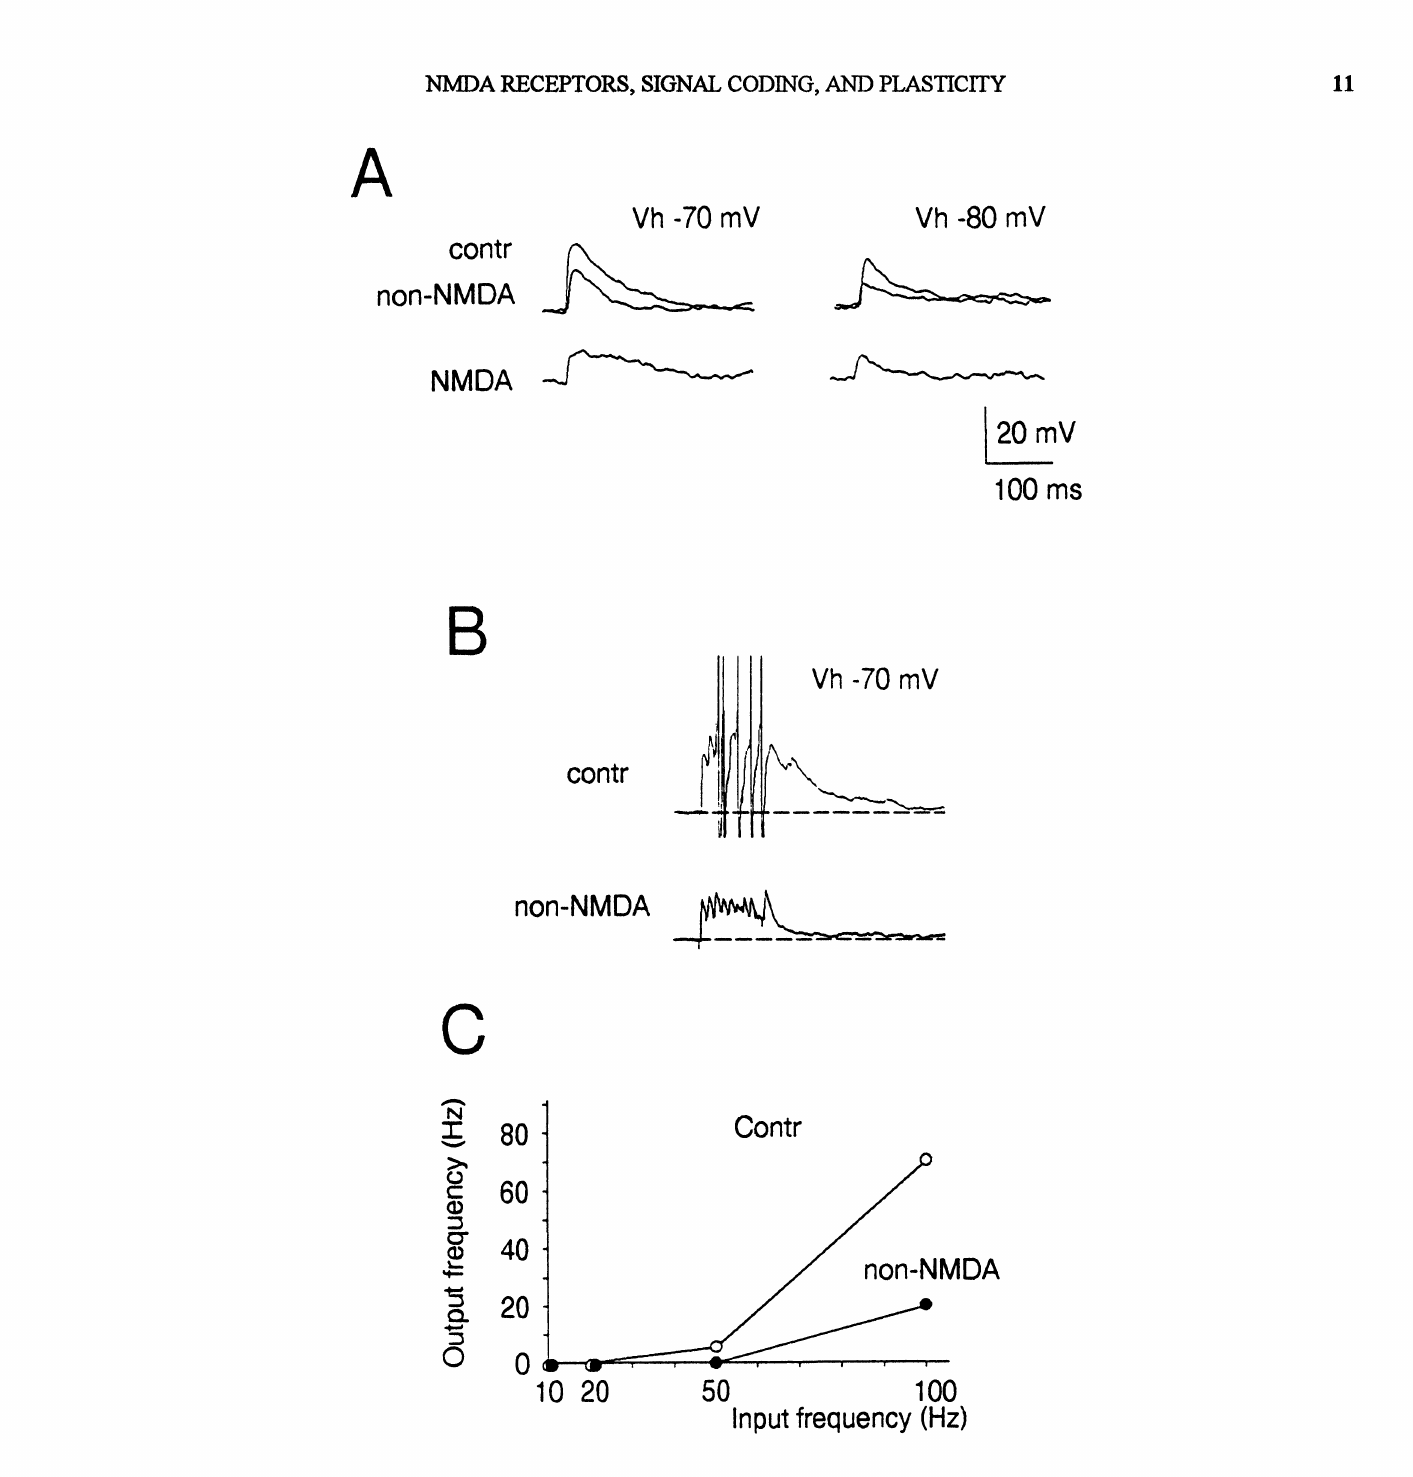
Fig. 2: NMDA receptor-mediated responses during mossy fiber activation of cerebellar granule cells. (A) The contribution of the NMDA current to EPSP elicited by low-frequency stimulation was uncovered by subtracting the